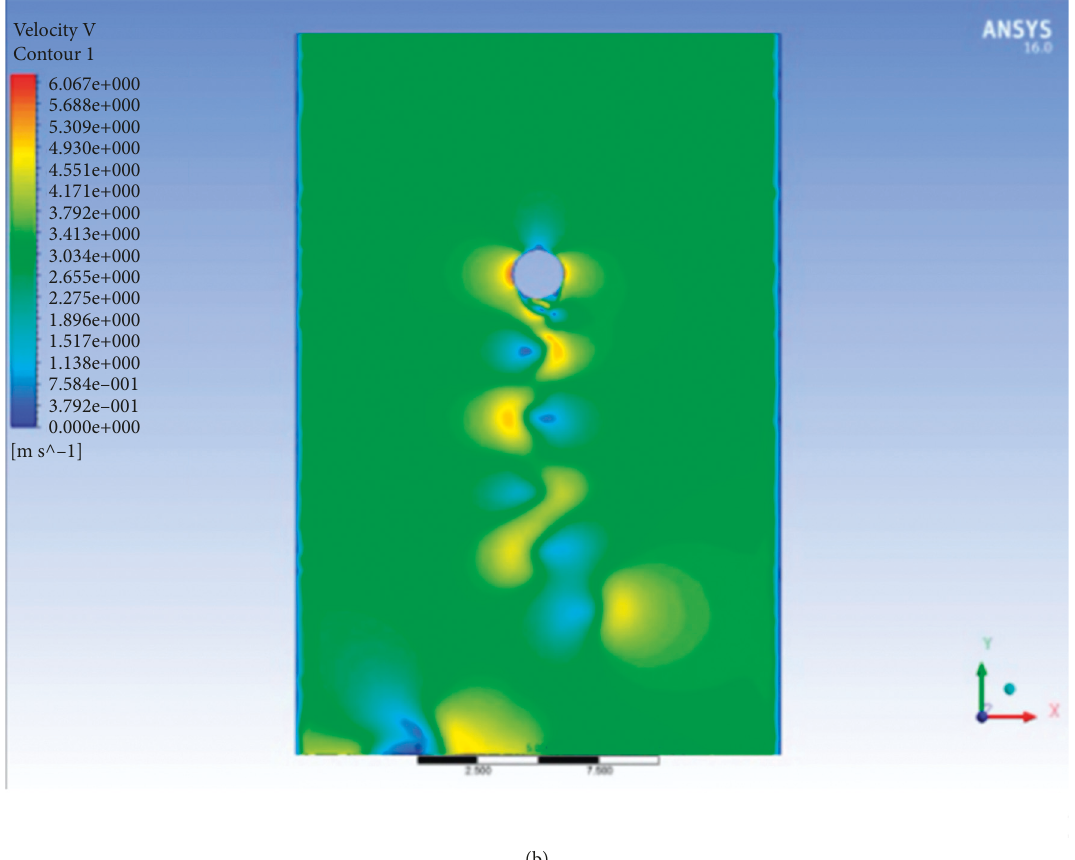
Figure 16: Top view of the flow velocity. (a) Distribution of the flow velocity. (b) K´arm´an vortex street in 2D simulation.